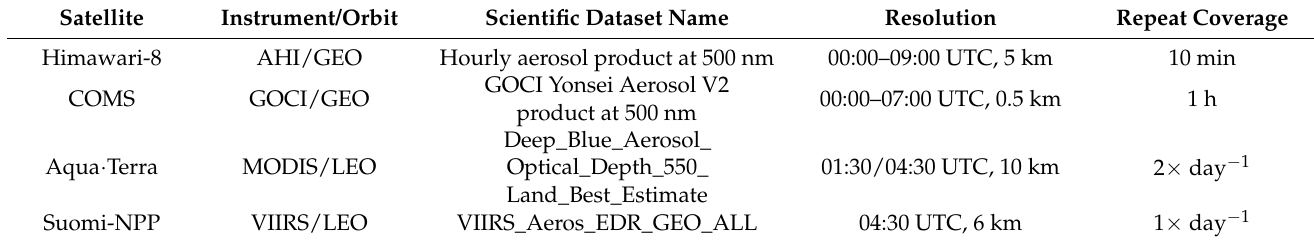
Table 1. Summary of satellites and instruments used in producing the composite AOD product. Satellite